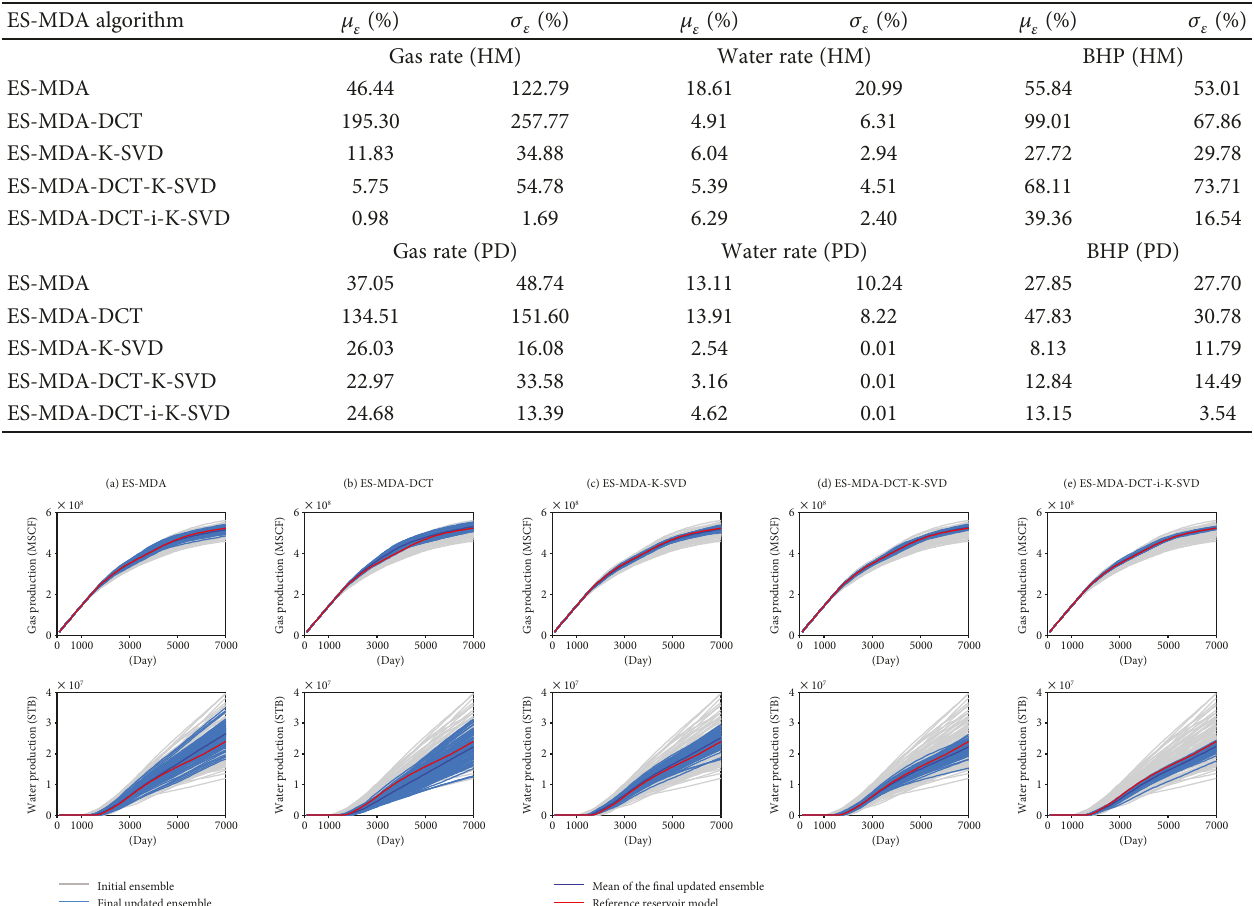
Table 5: Statistical parameters of history matching (HM) and prediction (PD) errors in terms of gas rate, water rate, and BHP (Case 1). μ σ ε refer to the mean and standard deviation of ensemble error, respectively.